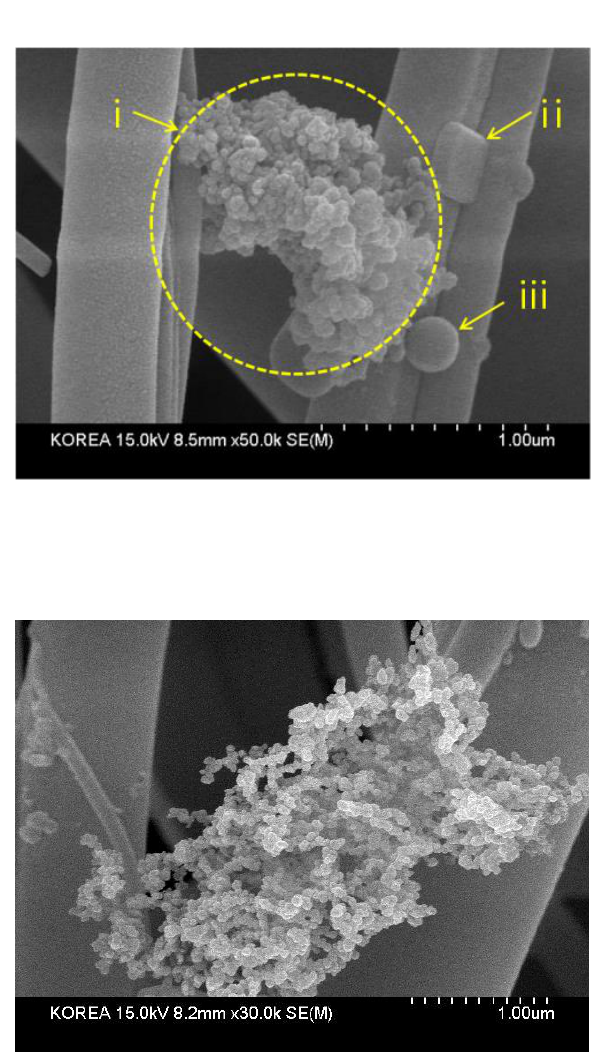
Figure 3. SEM images of ambient particles. (a) Particles in the 370nm group, collected on 3 January 2008. Regions and/or par- ticles marked by i, ii, and iii appear to be organic matter, sea salt, and a tar ball, respectively. (b) Aged soot aggregates with larger size and higher compactness in the 880nm group, collected on 14 April 2008.